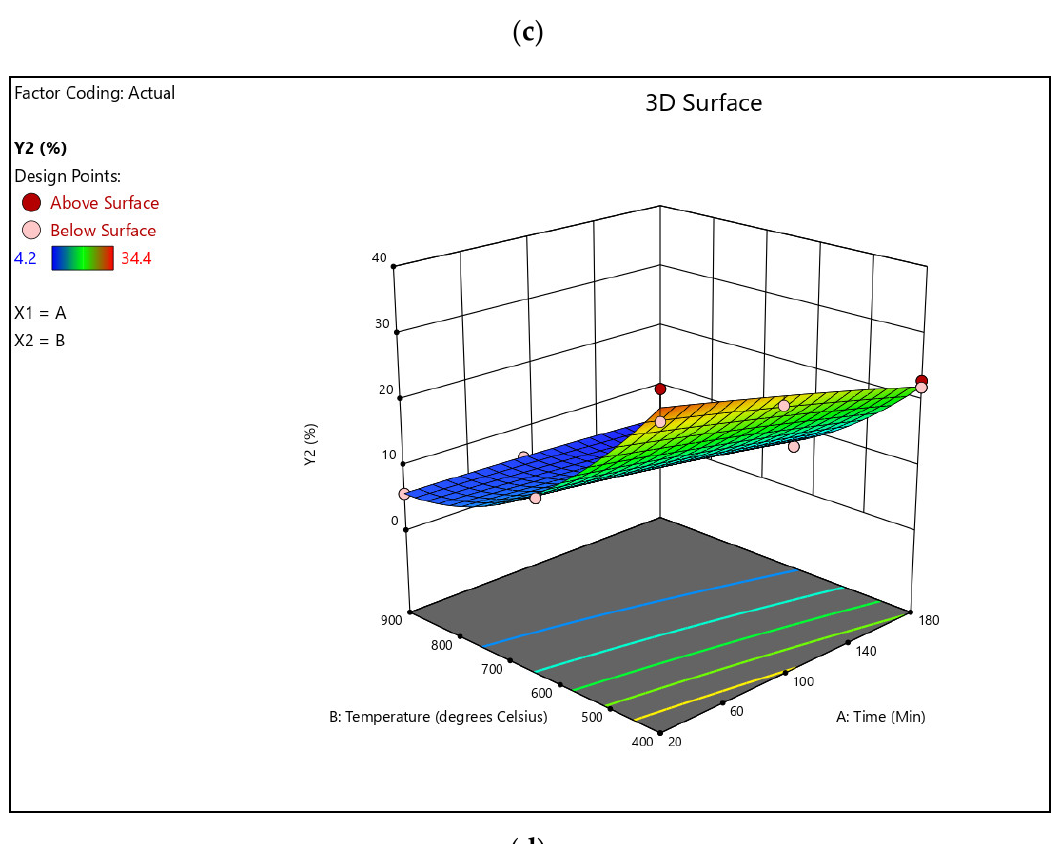
Figure 1. Comparison between the actual and predicted values for the ( a ) surface area and ( b ) yield and the response surface plots for the interaction effect of the temperature and time towards the ( c ) surface area and ( d ) yield.